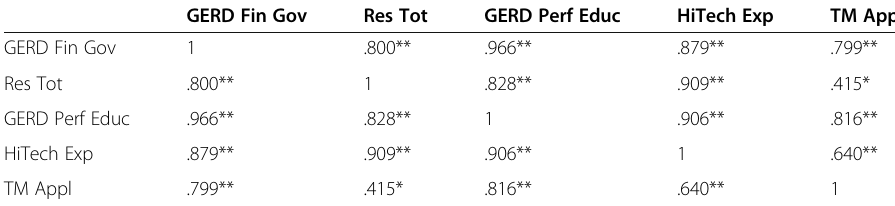
Table 4 Correlations matrix (Total) GERD Fin Gov Res Tot GERD Perf Educ